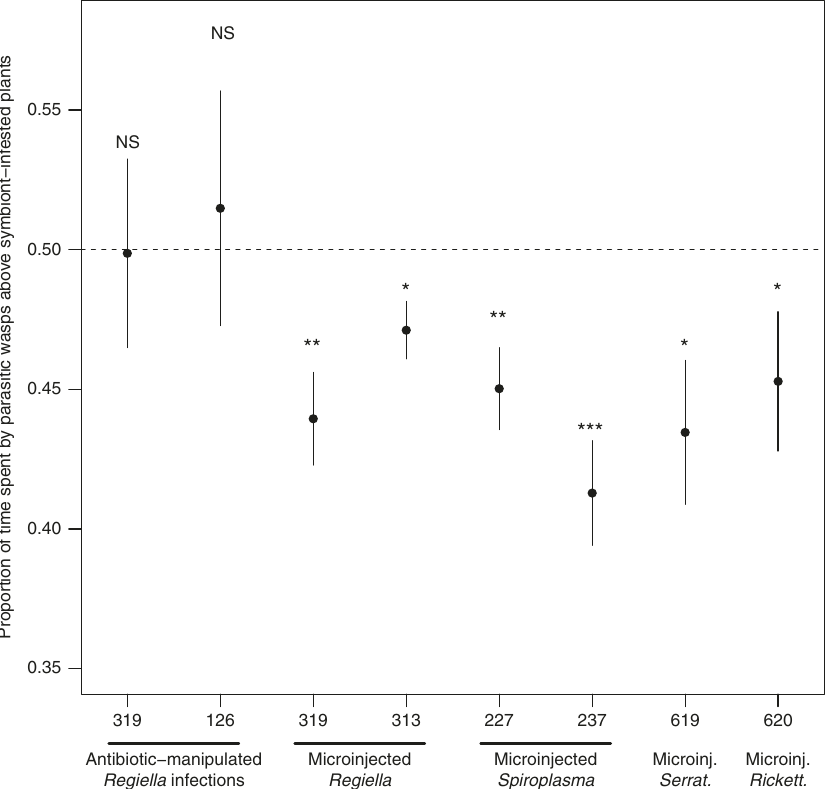
Fig. 5 Parasitic wasp preference for volatiles from plants infested with aphids with or without different endosymbiont species. Parasitic wasp ( Aphidius ervi ) response for volatiles emitted by Vicia faba plants infested with aphids ( Acyrthosiphon pisum ) with or without different symbiont species. For each symbiont strain tested, the bars show standard errors and the asterisks the signi fi cance of the deviation from no choice ( t -test: NS: non-signi fi cant; * p < 0.05; ** p < 0.01; *** p < 0.001). Regiella insecticola ( n = 10; column i — cured 319: t 9 = − 0.04, p = 0.4851; ii — cured 126: t 9 = 0.35, p = 0.6340; iii — microinjected 319: t 9 = − 3.65, p = 0.0026; iv — microinjected 313: t = − 2.81, p = 0.0102), Spiroplasma ( n = 10; column v — microinjected 227: t = − 3.40, p = 0.0039; vi — 9 9 microinjected 237: t 9 = − 4.65, p = 0.0006), Serratia symbiotica ( n = 10; column vii — microinjected 619: t 9 = − 2.54, p = 0.0158) and Rickettsiella ( n = 10; column viii — microinjected 620: t 9 = − 1.89, p = 0.0456). Natural symbiont infections were removed with antibiotics in the Regiella strains 319 and 126,